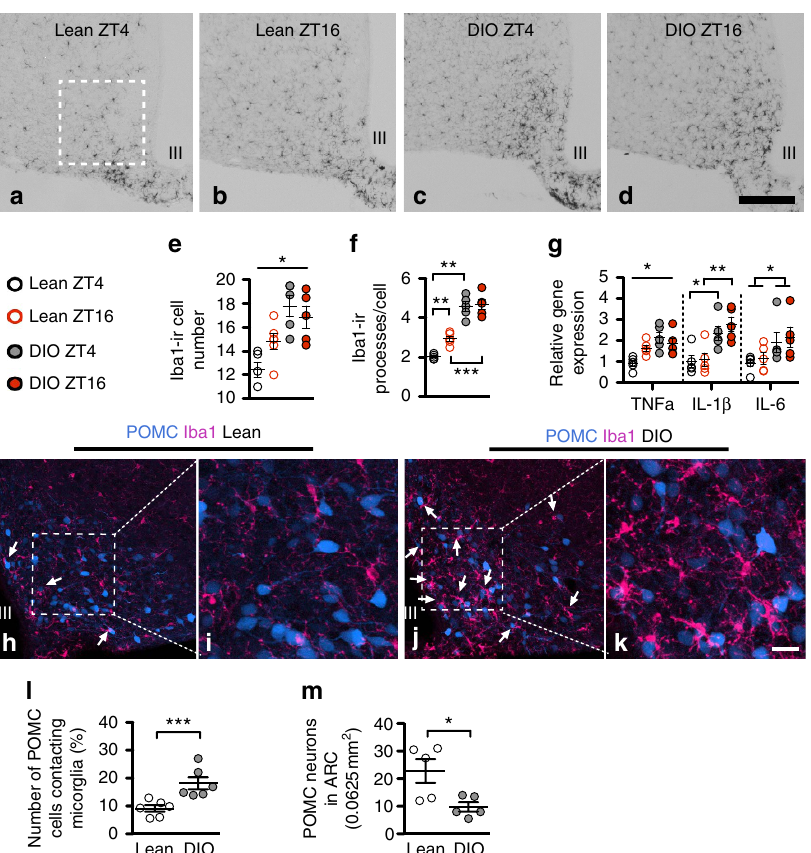
Figure 1 | Microglial activity in the arcuate nucleus (ARC) persistently elevated in DIO mice with their cell bodies topographically associated with POMC neurons. ( a – d ) Illustration of iba1-ir cells in the MBH. ( e – g ) For lean and DIO mice, comparing levels at ZT4 and ZT16, there was a significant interaction between time and body weight (BW; lean and DIO) on iba1-ir cell numbers (quantified in a 0.2 (cid:2) 0.2mm frame outlined by dashed lines in a ( n ¼ 5 for lean ZT4, DIO ZT4 and DIO ZT16; n ¼ 6 for lean ZT16, F (2,17) ¼ 4.504, P ¼ 0.049), and a significant effect of BW on iba1-ir cell numbers at ZT4 ( t 8 ¼ 4.695, P o 0.001 for lean versus DIO at ZT4). For the processes of each microglial cell, there was a significant interaction between time and BW, an effect of BW at ZT4 and ZT16, and an effect of time for lean ( F (2,17) ¼ 4.650, P ¼ 0.048; t 8 ¼ 9.476, P o 0.0001 for lean versus DIO at ZT4; t 9 ¼ 6.78, P o 0.0001 for lean versus DIO at ZT16; t 8 ¼ 3.545, P o 0.01 for ZT4 versus ZT16 in lean mice). There was a significant interaction between time and